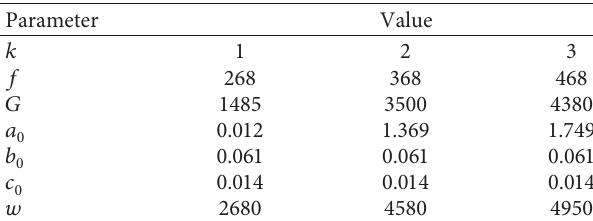
Figure 2: Delivery schedule and chromosome structure. (a) Delivery schedule. (b) Chromosome structure. Table 2: Parameter setting for refrigerated vehicles.